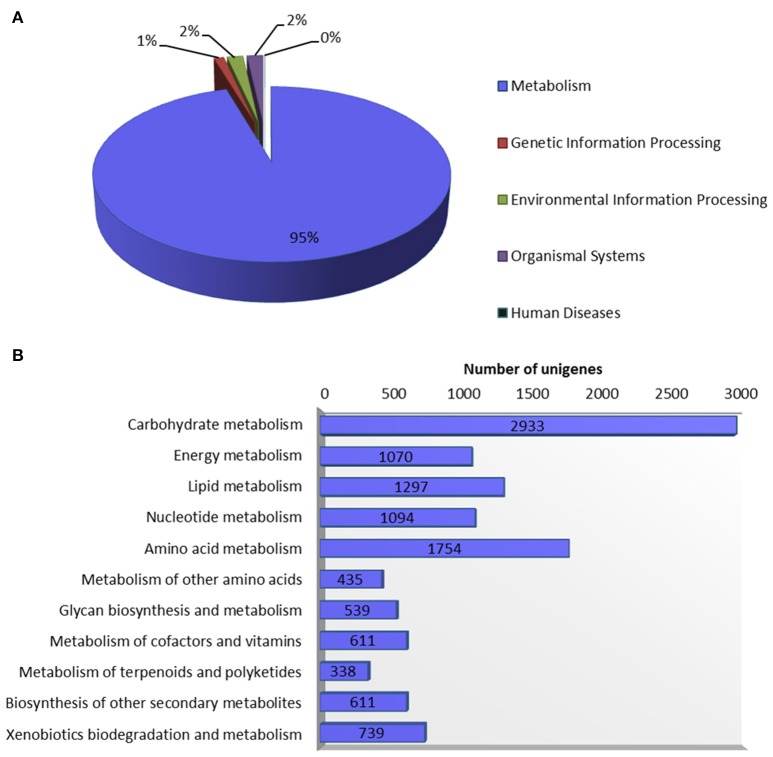
Annotation of guar leaf transcriptome in KEGG database. (A) Distribution of unigenes into KEGG biological categories. (B) Classification of unigenes in KEGG “metabolism” category.